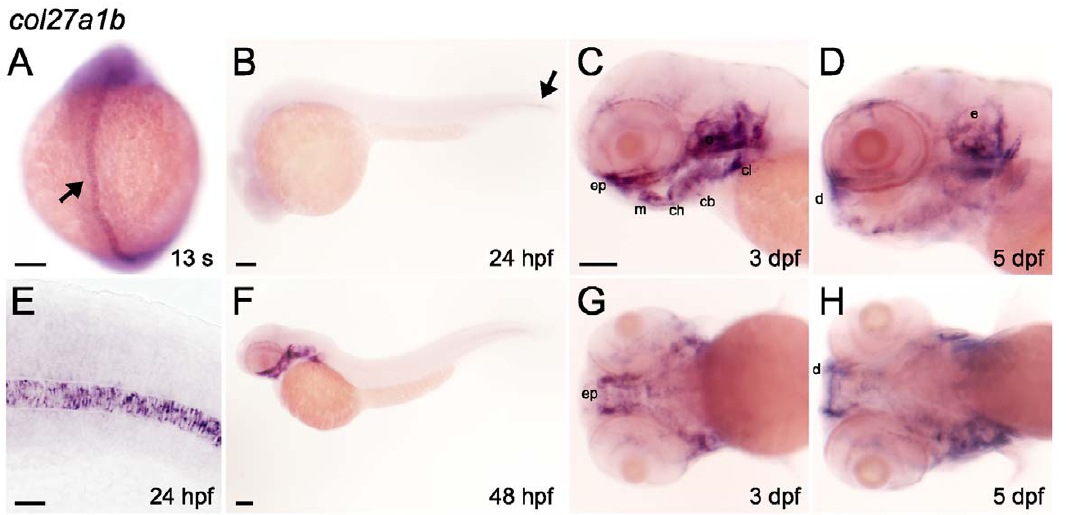
Figure 3. col27a1b is expressed in notochord and cartilage. col27a1b was expressed throughout the notochord at 13 somites (A) but by 24 hpf (B) was restricted to the distal tip of the tail (black arrow). (E) col27a1b expression in the notochord was restricted to the notochord itself and was not present in surrounding structures. (F) Expression of col27a1b in cartilage was observed beginning at 48hpf. Cartilage expression was also seen at 3 dpf (C, G) and 5 dpf (D, H), but it was diffuse and individual cartilage structures were not easily distinguished. Scale bar in E represents 20 m m. Scale bars in remaining images represent 100 m m. Scale bar in C applies to D, G, and H. cb, ceratobranchial arches; ch, ceratohyal; cl, cleithrum; d, dentary; e, ear; ep, ethmoid plate; m,